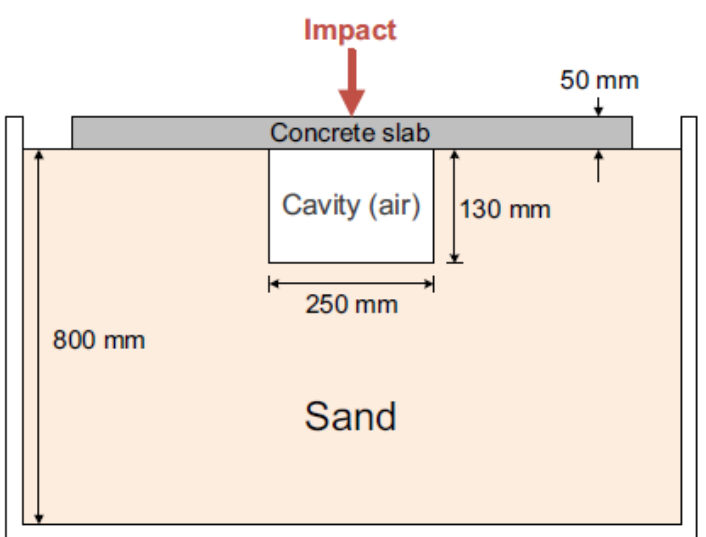
Figure 14. The schematic drawing of the impact echo test. Reprinted from Tunnelling and Under- ground Space Technology, Volume 65, Kang, J.M.; Song, S.; Park, D.; Choi, C. Detection of Cavities around Concrete Sewage Pipelines Using Impact-echo Method, Page 1–11, Year 2017 with permission from Elsevier